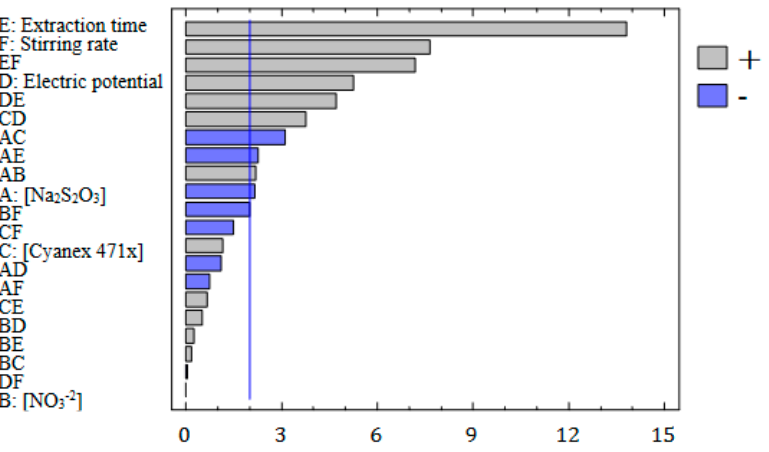
Figure 1. Standardized ( p = 0.05) Pareto chart, representing the estimated effects of main factors and interactions on silver preconcentration.